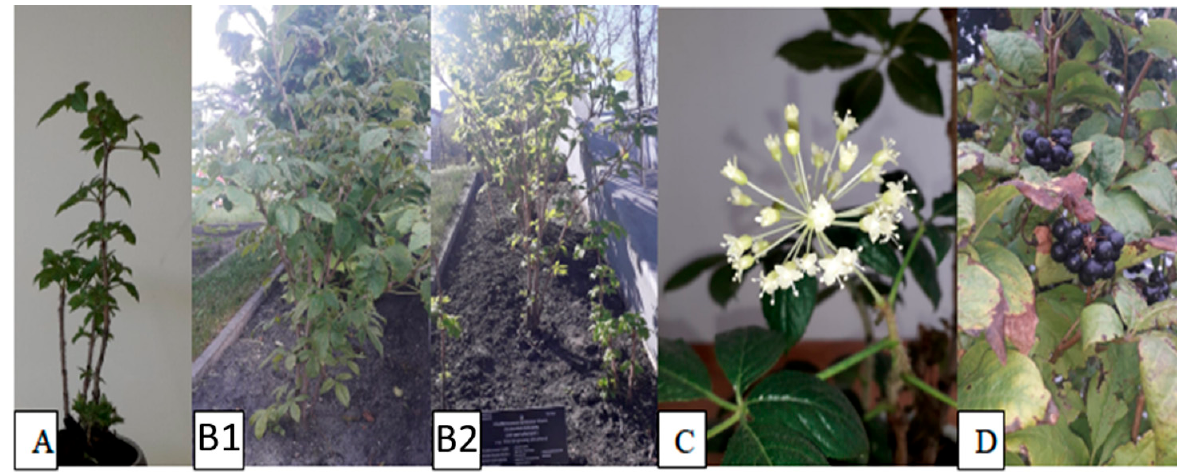
Figure 1. Morphological characteristics of the investigated species; ( A ) 1-year-old plant, general morphology; ( B1 , B2 ) 4-year-old plants growing in the crop field, general morphology; ( C ) flowers; ( D ) mature fruits.